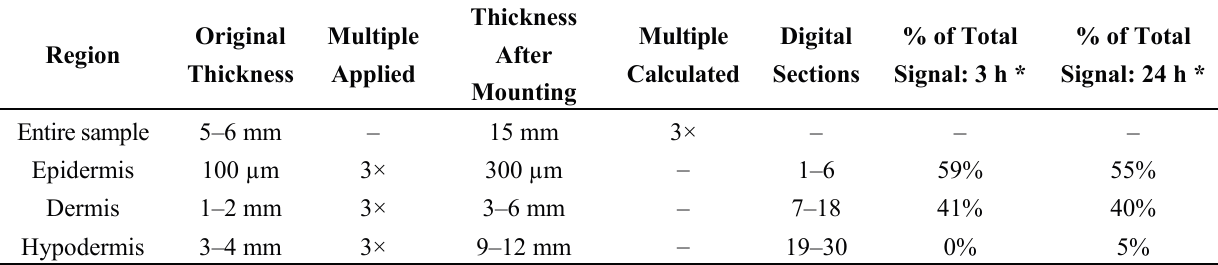
Table 1. Estimated layer divisions in mounted skin specimens and diffusion